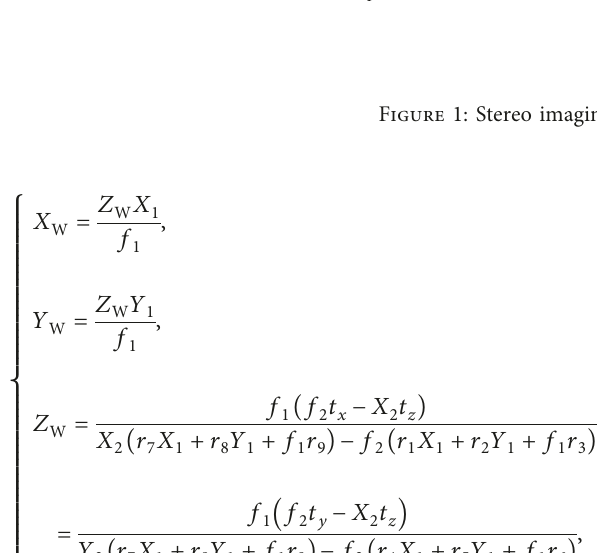
Figure 1: Stereo imaging model of binocular